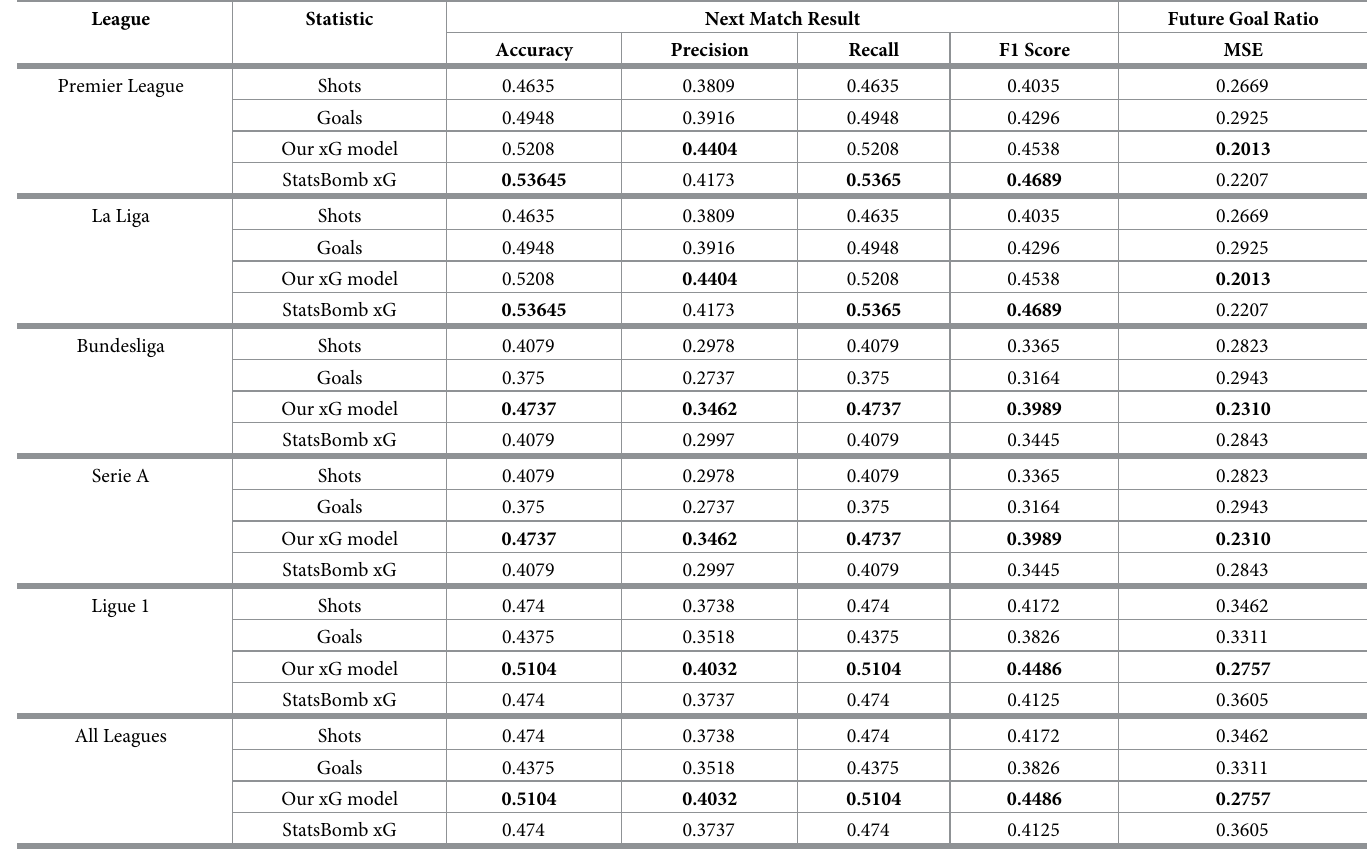
Table 4. Test data results for comparison between expected goals statistic and traditional